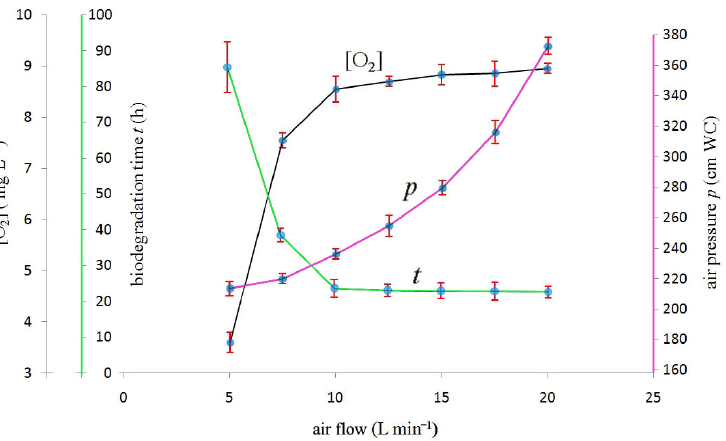
Figure 2. Black line: Dissolved oxygen concentration [O 2 ] (mg (O 2 ) L − 1 ) values (at 20 °C) measured by the oximeter (15) on the top of bioreactor (21) at the beginning of each biodegradation experiment in the ordinate vs. air flow (L min − 1 ) in the abscissa. Green line: The ordinate time (h) required fulfilling the complete substrate biodegradation. For the sake of clarity, error bars of time (which represent the standard deviation of five measurements) are exaggerated by a factor of 2. Purple line: The ordinate air pressure (cm of water column, i.e., cm WC) measured by the pressure gauge (37). For the sake of clarity, air pressure error bars (which represent the standard deviation of five measurements) are exaggerated by a factor of 5.